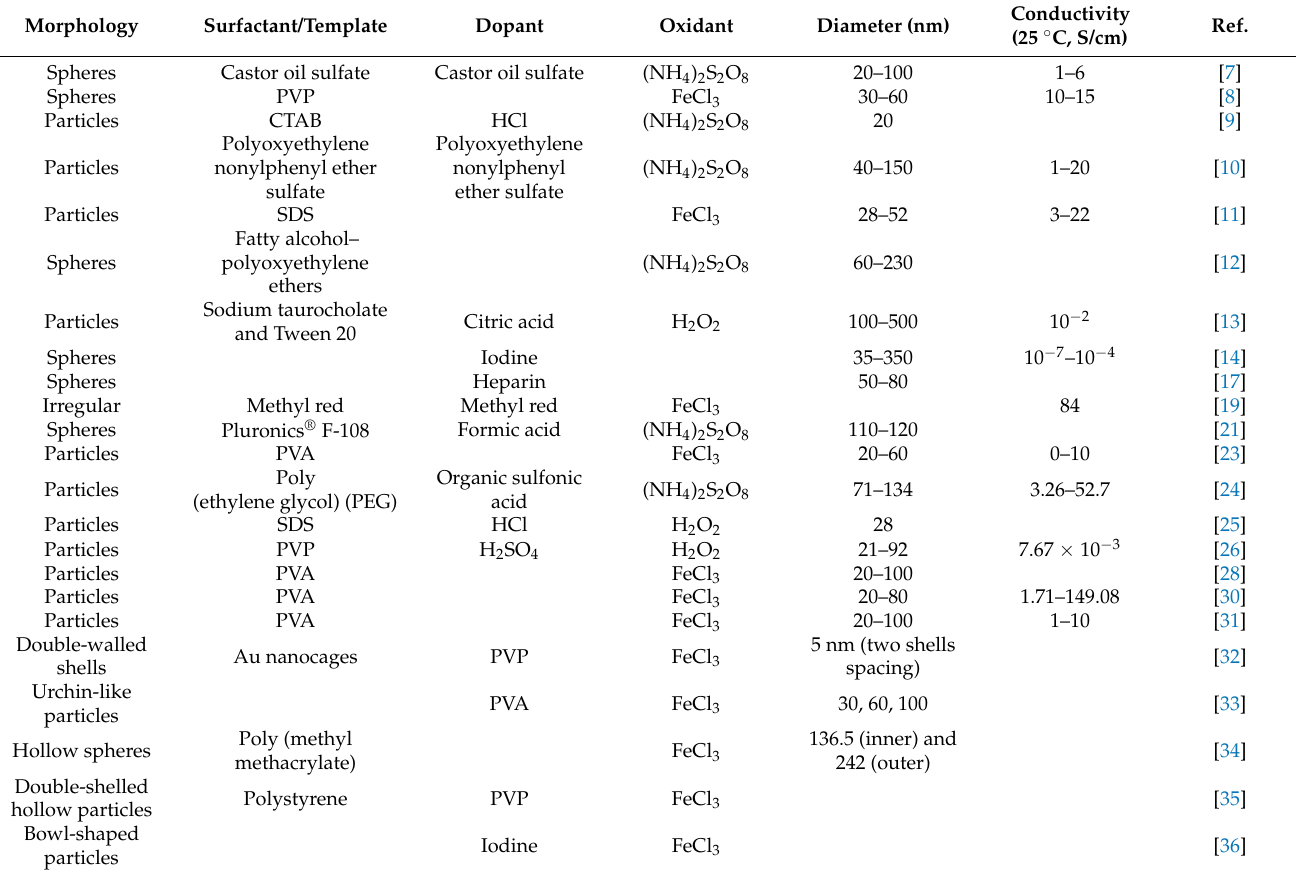
Table 1. A summary of synthetic conditions, size and conductivity of PPy